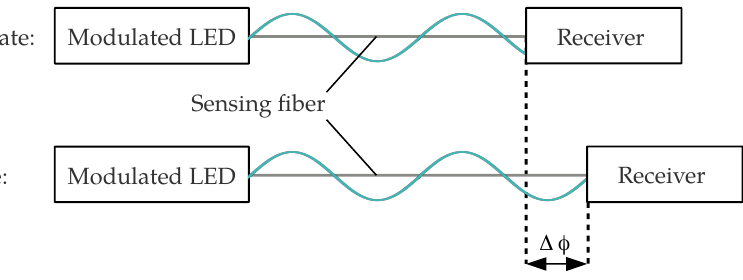
Figure 1. Change of the modulation phase due to